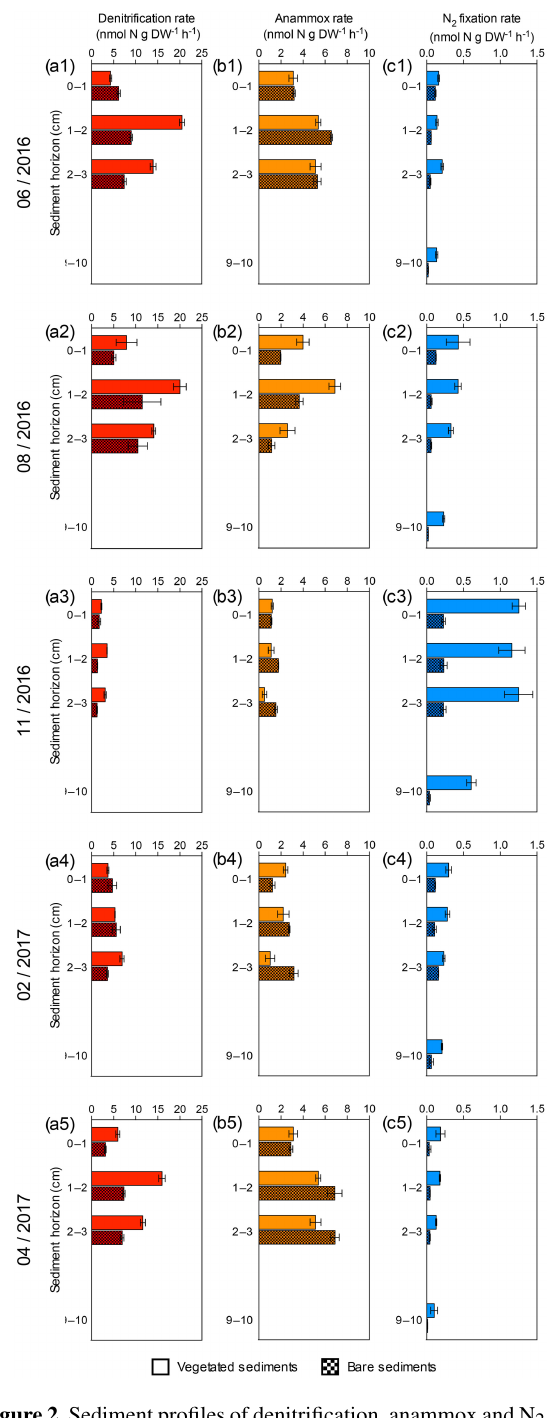
Figure 2. Sediment profiles of denitrification, anammox and N 2 fix- ation rates at five sampling times. (a1–a5) Sediment denitrification rates in vegetated (red) and bare (red square pattern) sediment hori- zons. (b1–b5) Sediment anammox rates in vegetated (orange) and bare (orange square pattern) sediment horizons. (c1–c5) Sediment N 2 fixation rates in vegetated (blue) and bare (blue square pattern) sediment horizons. Error bars indicate